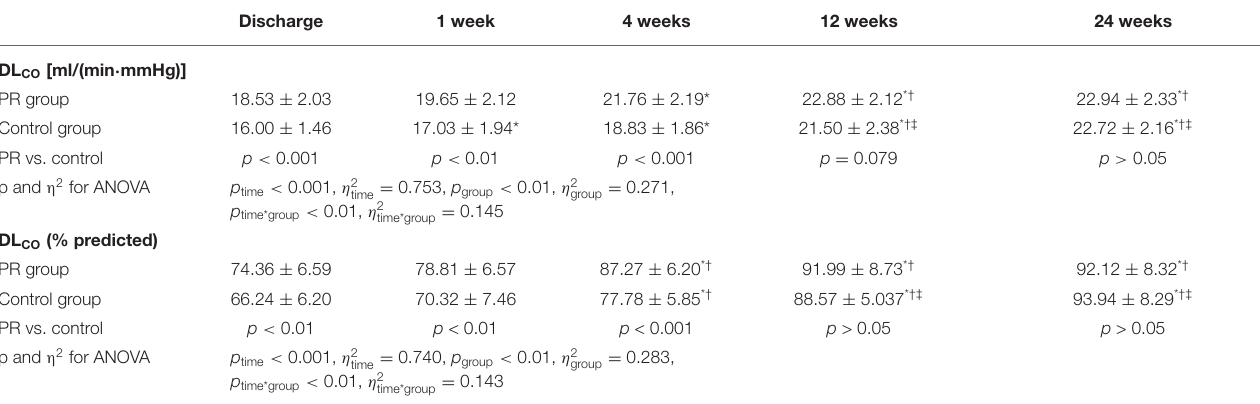
TABLE 6 | Diffusing capacity of the lung for carbon monoxide.